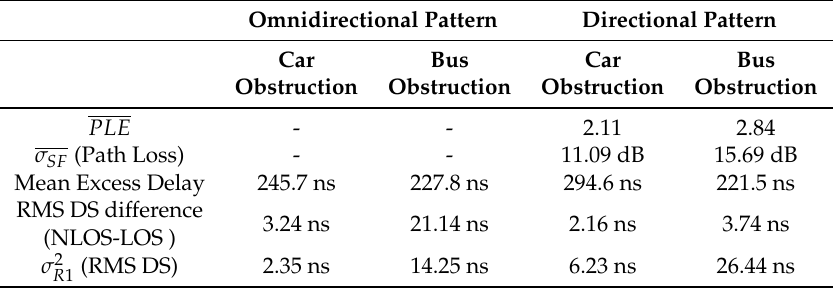
Table 3. Simulation Results.